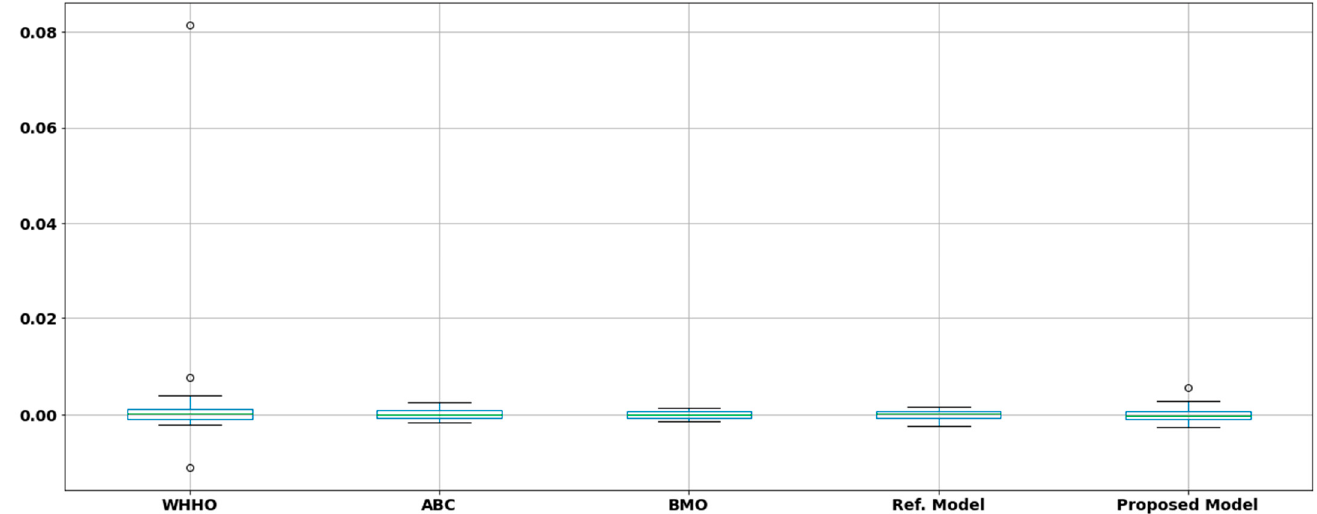
Figure 9. Boxplot of the error in current for the proposed model and other models from the literature (WHHO [14], ABC [36], and BMO [38]) compared to the original data regarding the R.T.C. France model.